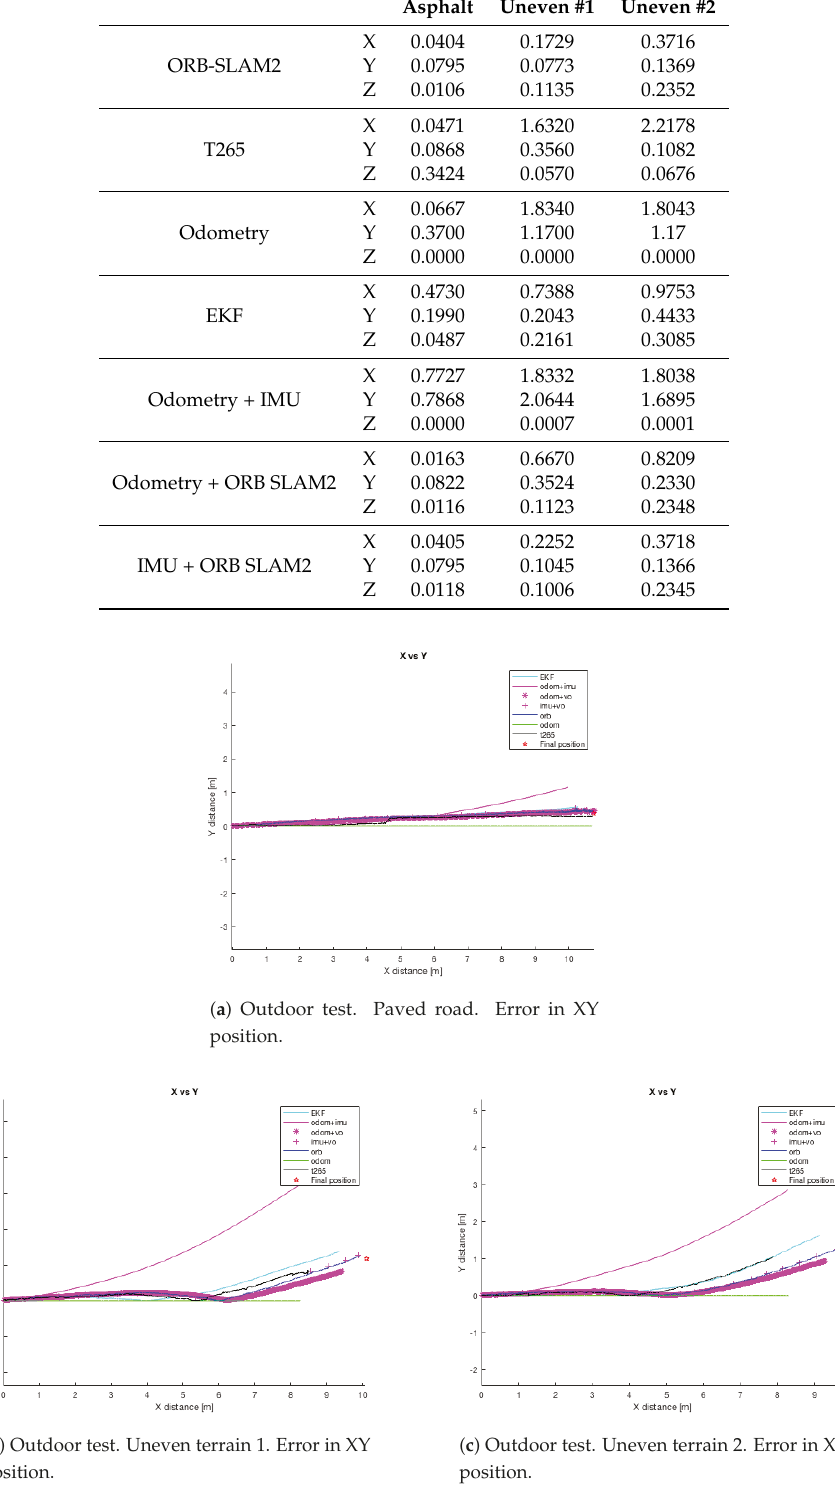
( b ) Paved road test Z error. Figure 29. Outdoor test #1.